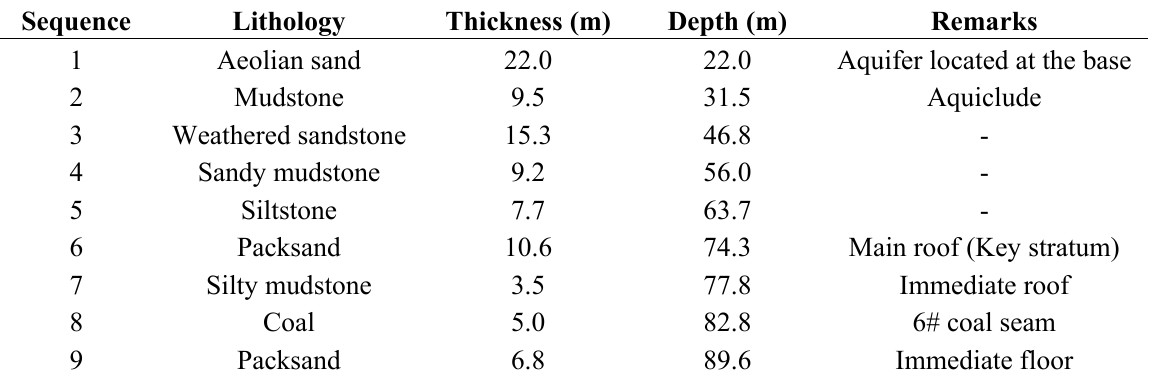
Table 1. The placement and composition of the strata in the 6203# coalface.